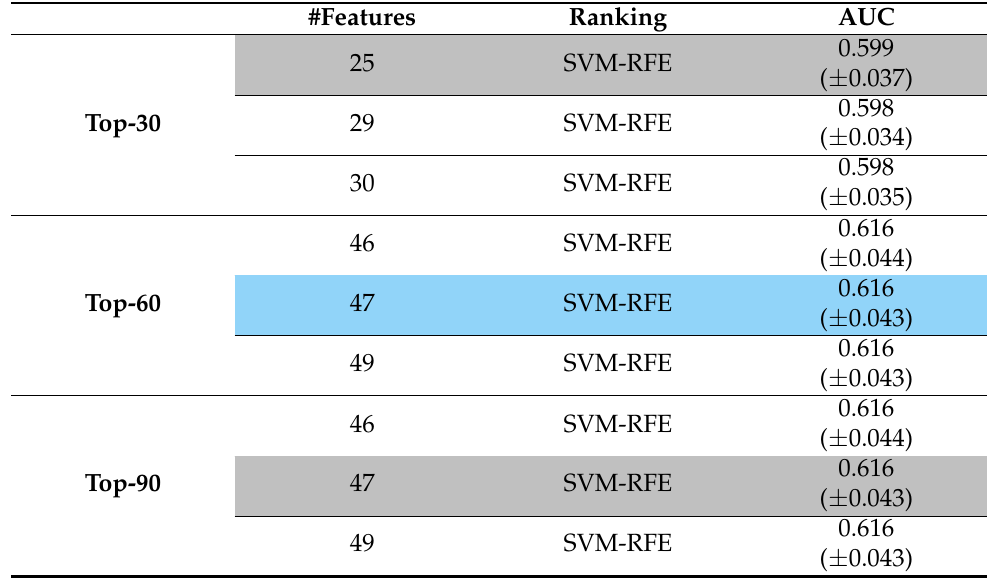
Table 5. Logistic Regression classifier. In gray background the number of features with the best result. In blue background the best result over all the